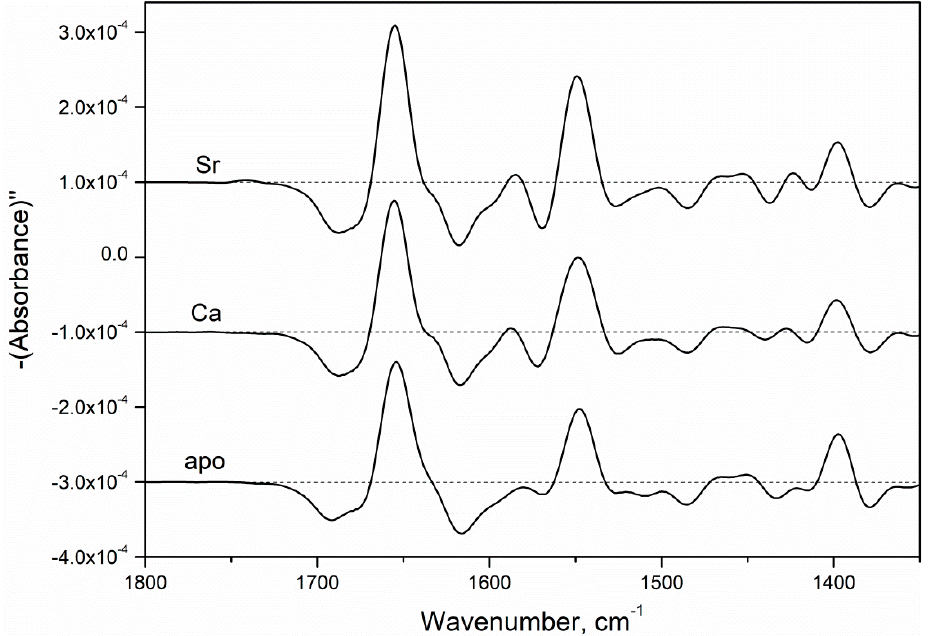
Figure 5. Second-derivative FTIR spectroscopy spectra of apo- and Sr 2+ /Ca 2+ -loaded (10 mM) α -PA (3 mM) at 20 °C (10 mM H 3 BO 3 -KOH, pH 9.0).